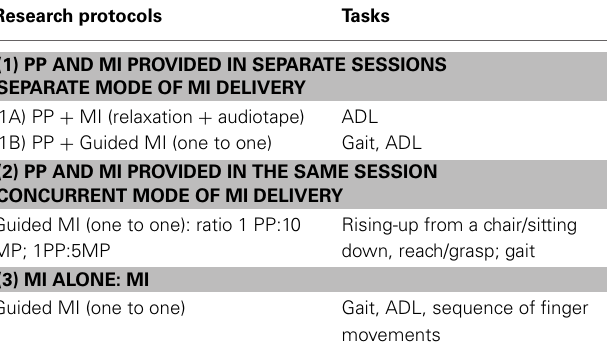
Table 1 | Modes of MI delivery and examples of